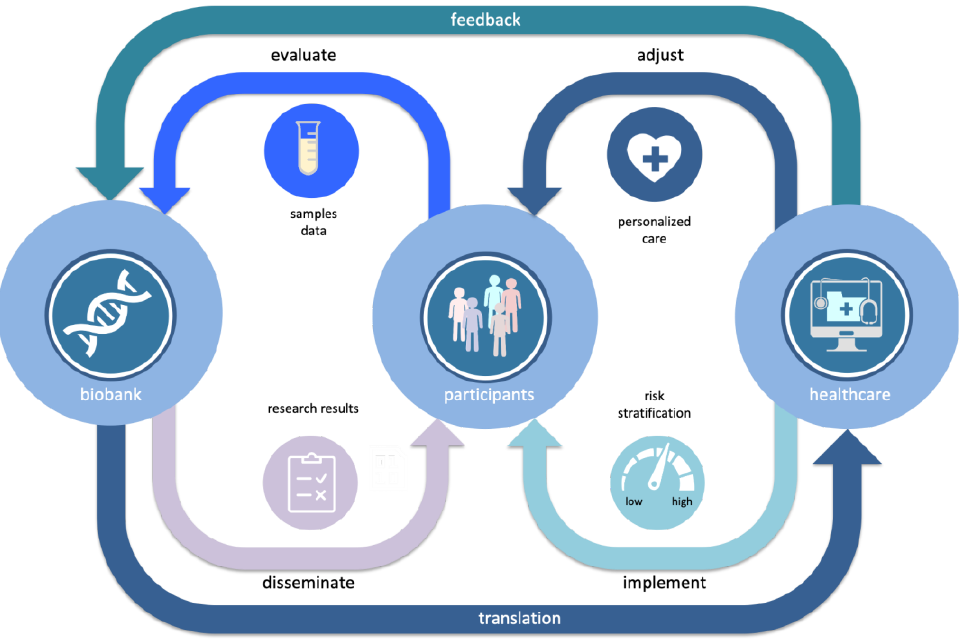
Figure 3. Learning healthcare cycle, where through continuous bi-directional interaction between a population biobank and health care systems new personalized genome-based information from biobank is gradually incorporated into the general health care.